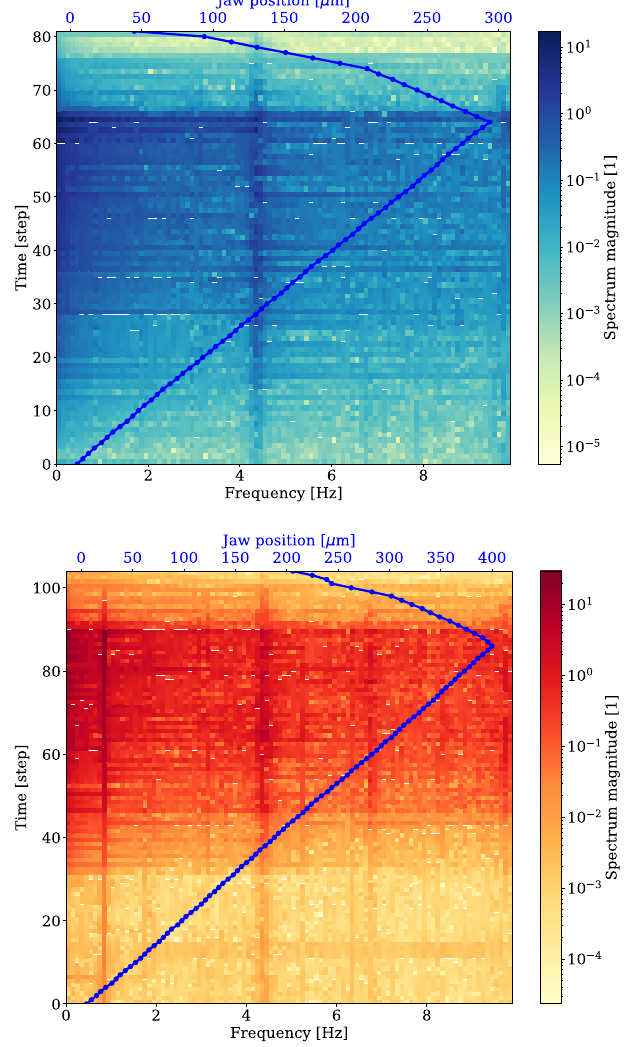
FIG. 18. Frequency analysis of the beam 1 vertical (top) and beam 2 vertical (bottom) response as a function of the steps (gap change). Distinct peaks around 1, 4.4, and 6.7 Hz can be seen. The blue line represents the moving jaw position as a function of the experiment step.